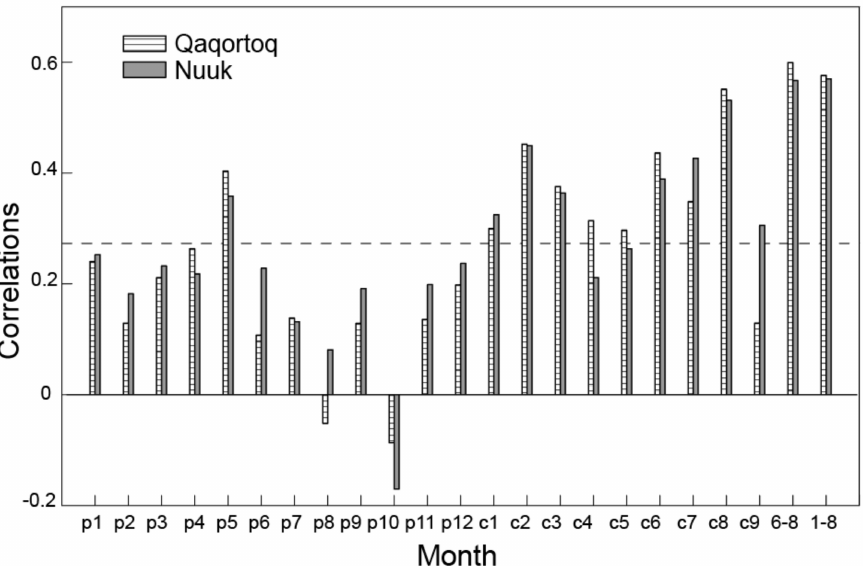
Figure 4. Correlations between tree ring δ 18 O with monthly temperature at Nuuk and Qaqortoq station during the period of 1950–1999. Numbers in x -axis represent the months of the year, and numbers with a “p” and “c” prefix indicate the previous year and current year, respectively. The dashed line indicates the 95% confidence level